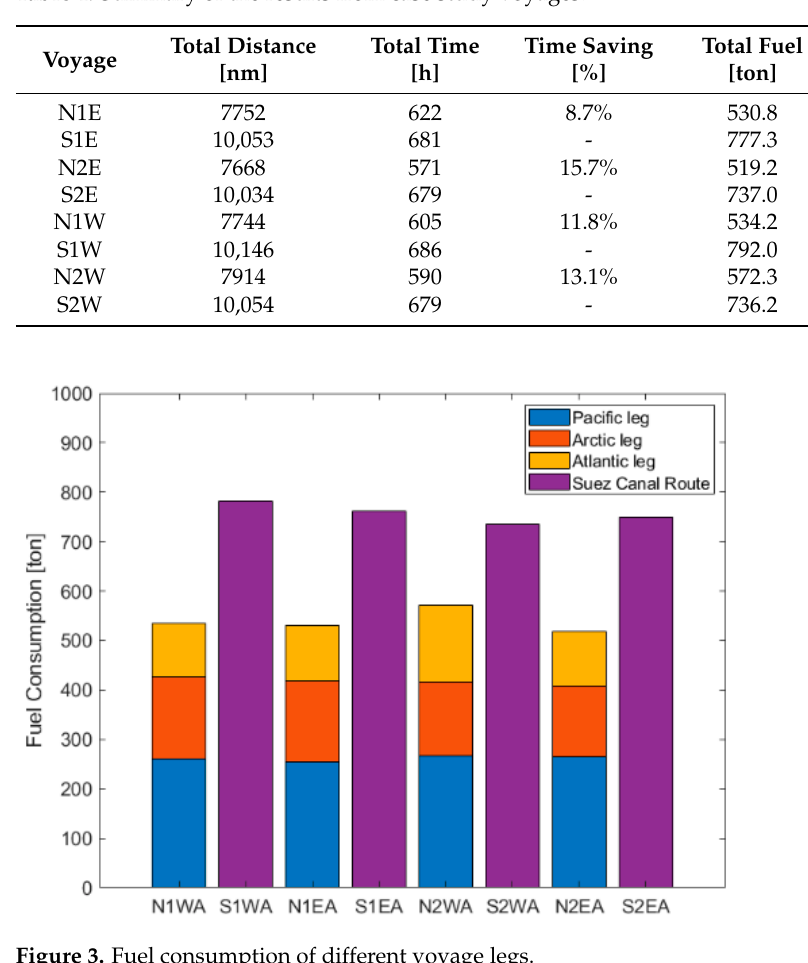
Table 4. Summary of the results from case study voyages.